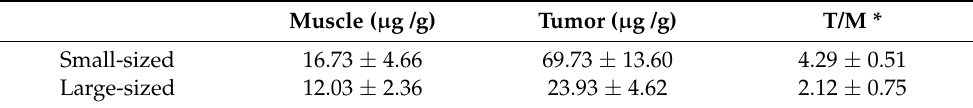
Table 2. Boron content in tumor and muscle determined by inductively coupled plasma mass